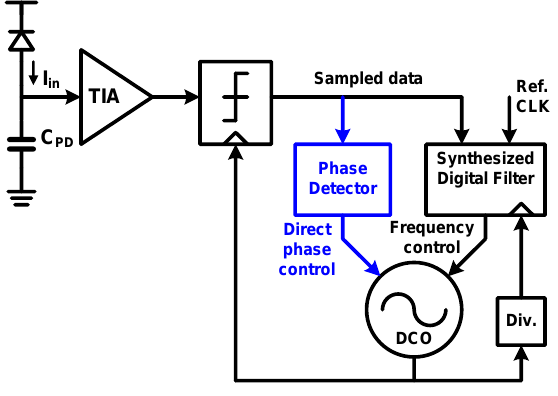
Figure 45. All-digital CDR presented in [74].